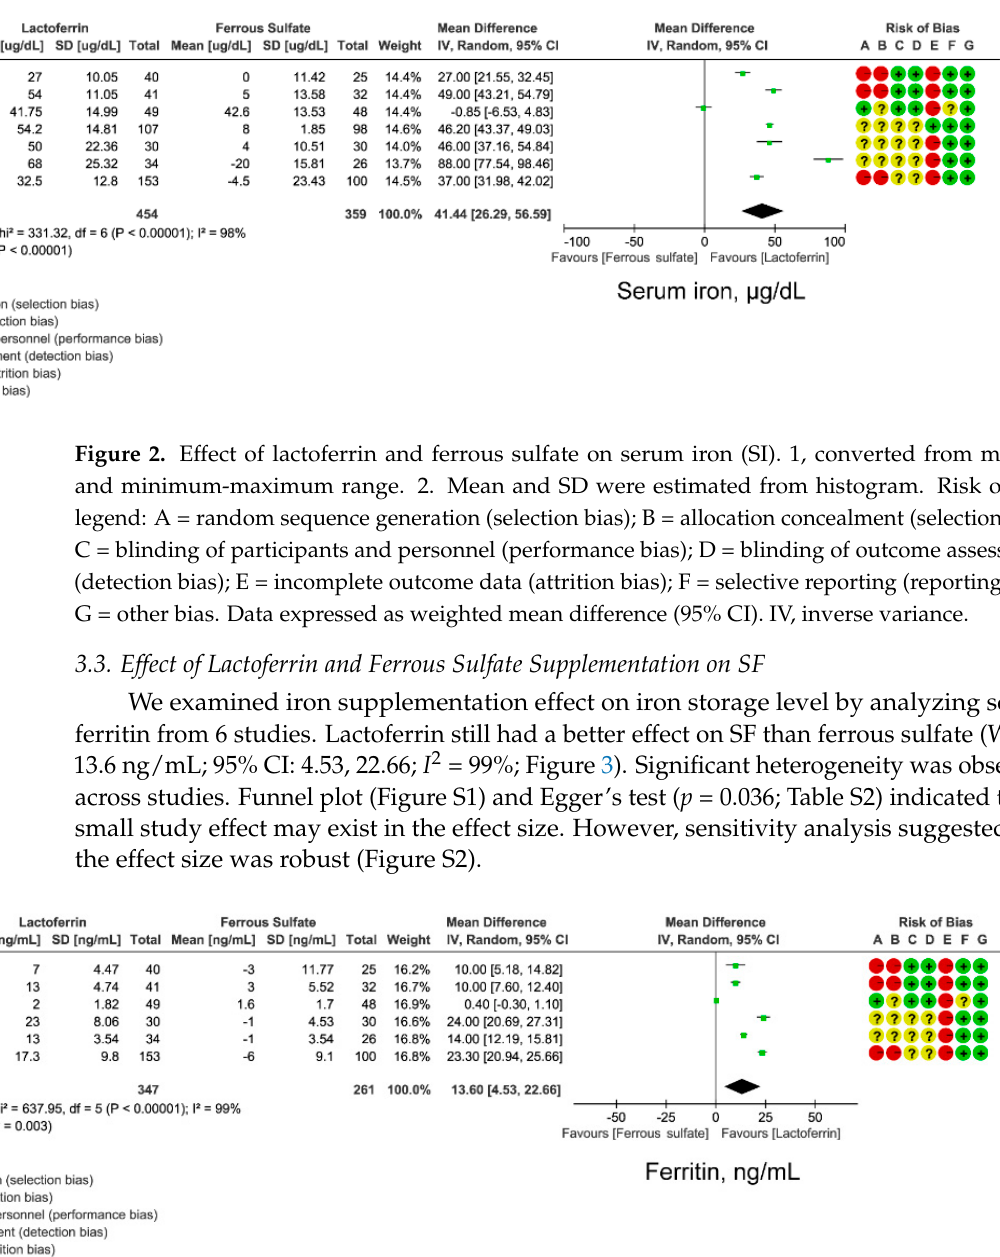
Figure 1. Study identification and selection flow diagram.